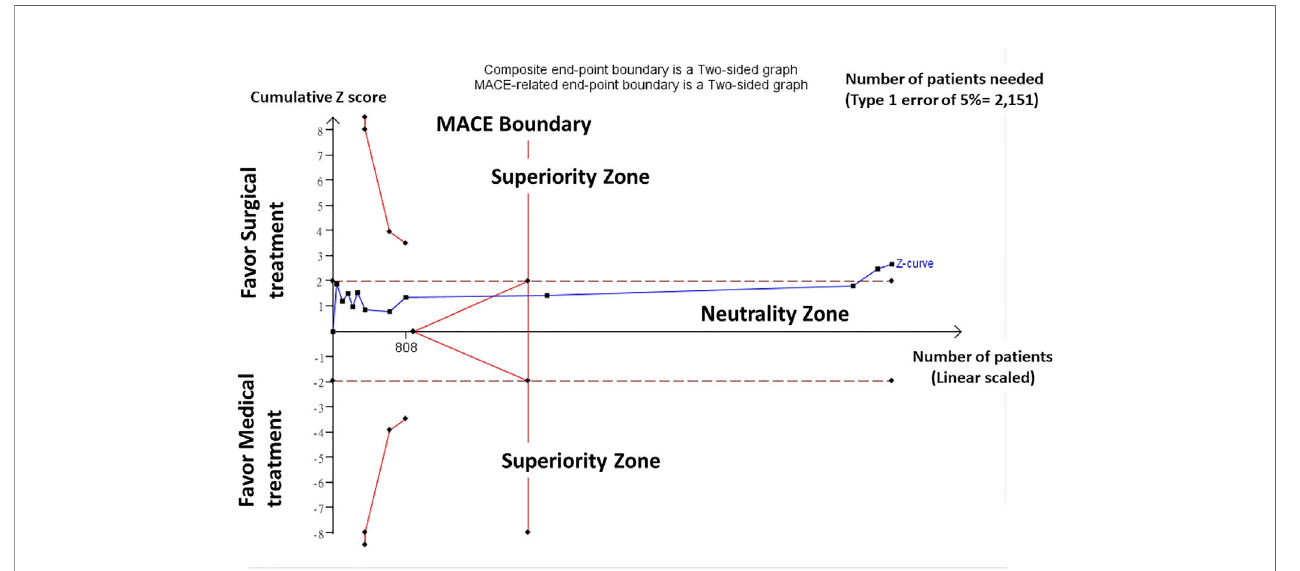
FIGURE 2 | Trial Sequential Analysis (TSA). Result of TSA showed homogeneity of results was stable and around 2151 patients would be needed to reach a stopping boundary of superiority. The Z-curve was parallel to superior boundary, but crossed the neutrality boundary including all trials. Trials of patients yielded enough information size to conclude that the current evidence reached preliminary conclusion for supporting the superior outcome of surgical treatment over medical